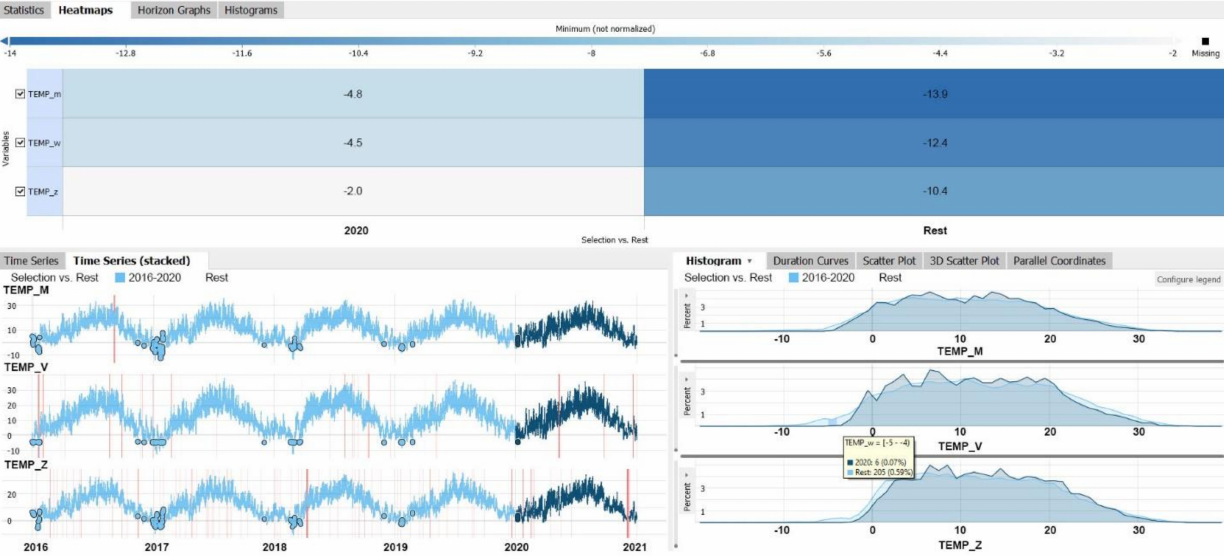
Figure 5. Composite view of comparative temperature time-series analysis with focus on temperature minima: heatmap view ( up ), time-series distribution ( down left ), frequency distribution ( down right